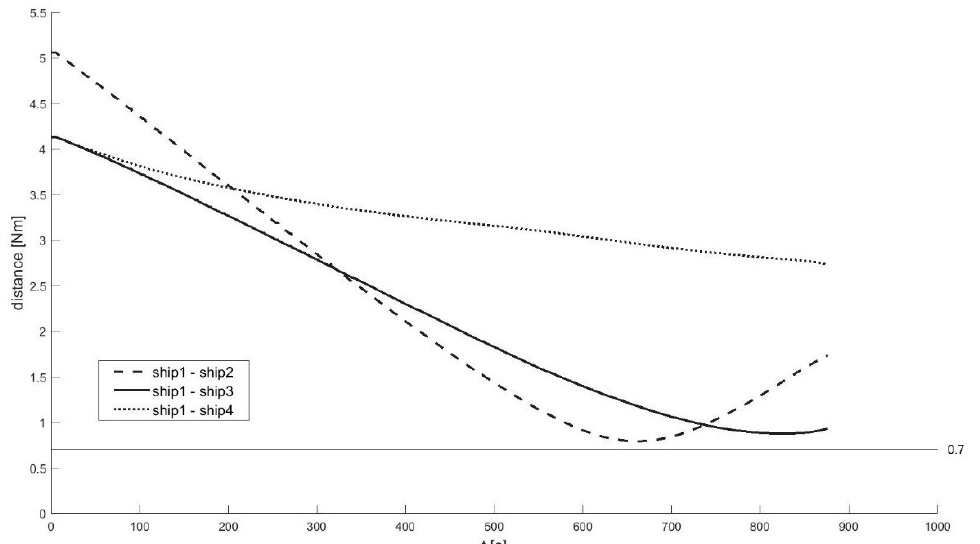
Figure 9. Execution of Scenario 1 with the anti-collision manoeuvre worked out by Ship 1 — ship movement trajectories.